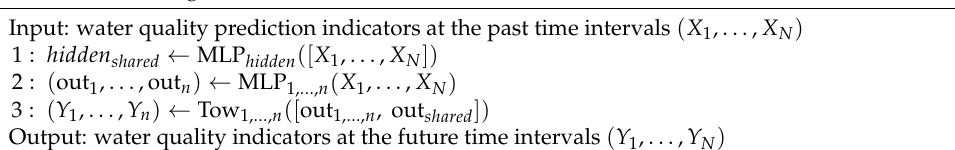
Algorithm 2: Multi-indicator water quality prediction based on soft parameter sharing multi-task